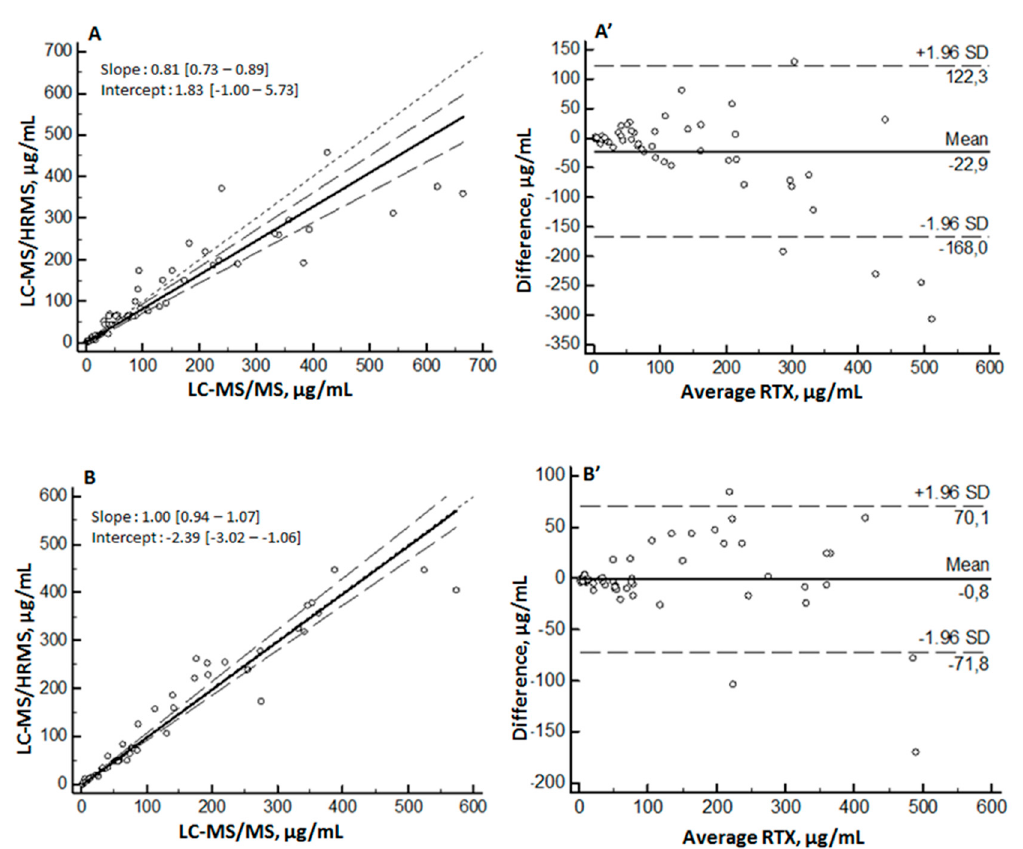
Figure 7. Inter-laboratory comparison of rituximab (RTX) quantification. Passing–Bablok regression (left), with solid line representing regression line and dashed line representing 95% confidence interval for regression line, and Bland–Altman difference-plot (right). Comparison between results obtained with the pQVQ and albumin depletion protocol on LC- MS/HRMS and LC-MS/MS ( A ), ( A’ ) and comparison between results obtained with pQVQ and IgG-immunocapture protocol with LC-MS/HRMS and LC-MS/MS ( B ), ( B’ ). SD: standard deviation.